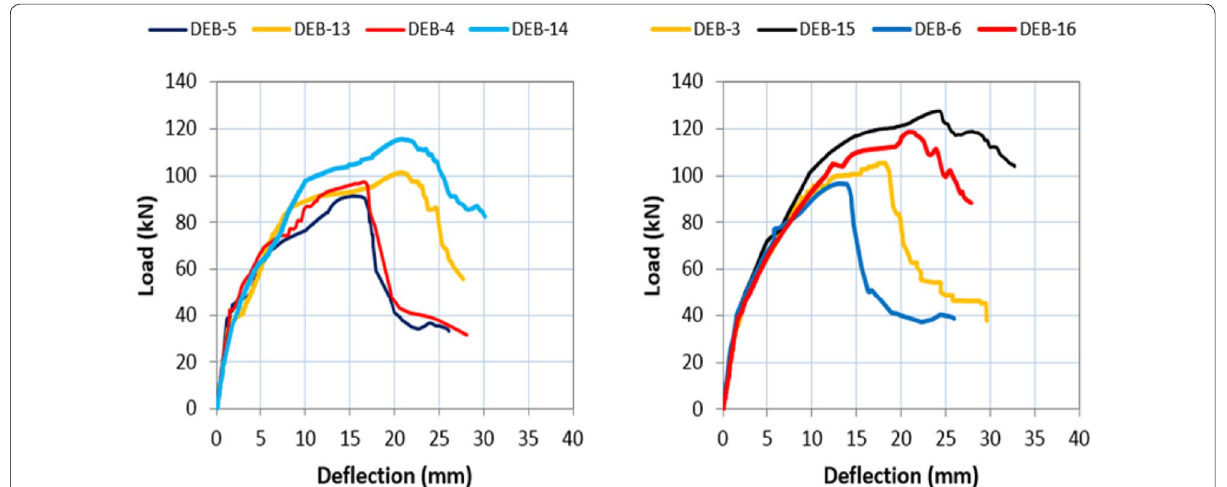
Fig. 21 Comparison of load–deflection relationship in the first and second group (For DEB-5,-13,-4,-14,-3,-15,-6 and DEB-16).